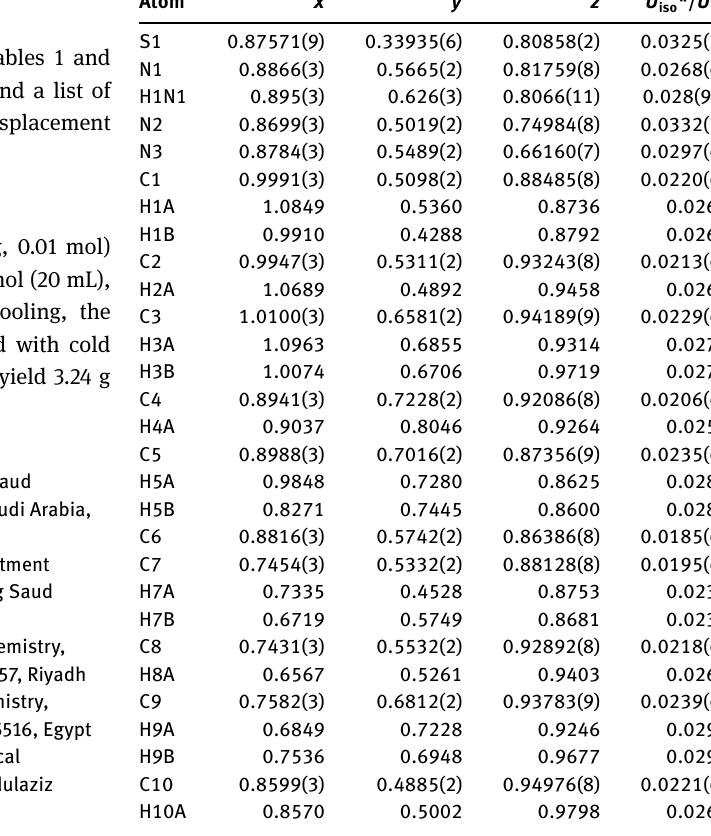
Table 2: Fractional atomic coordinates and isotropic or equivalent isotropic displacement parameters (Å 2